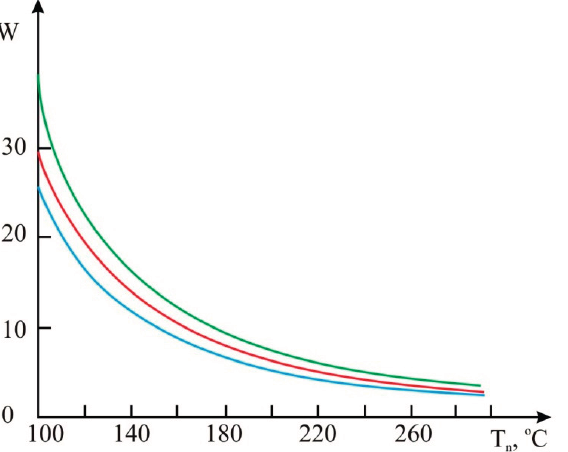
Figure 8. The graphs of temperature dependence on fuel consumption: gasoline; diesel fuel; biofuels Т n , °C.